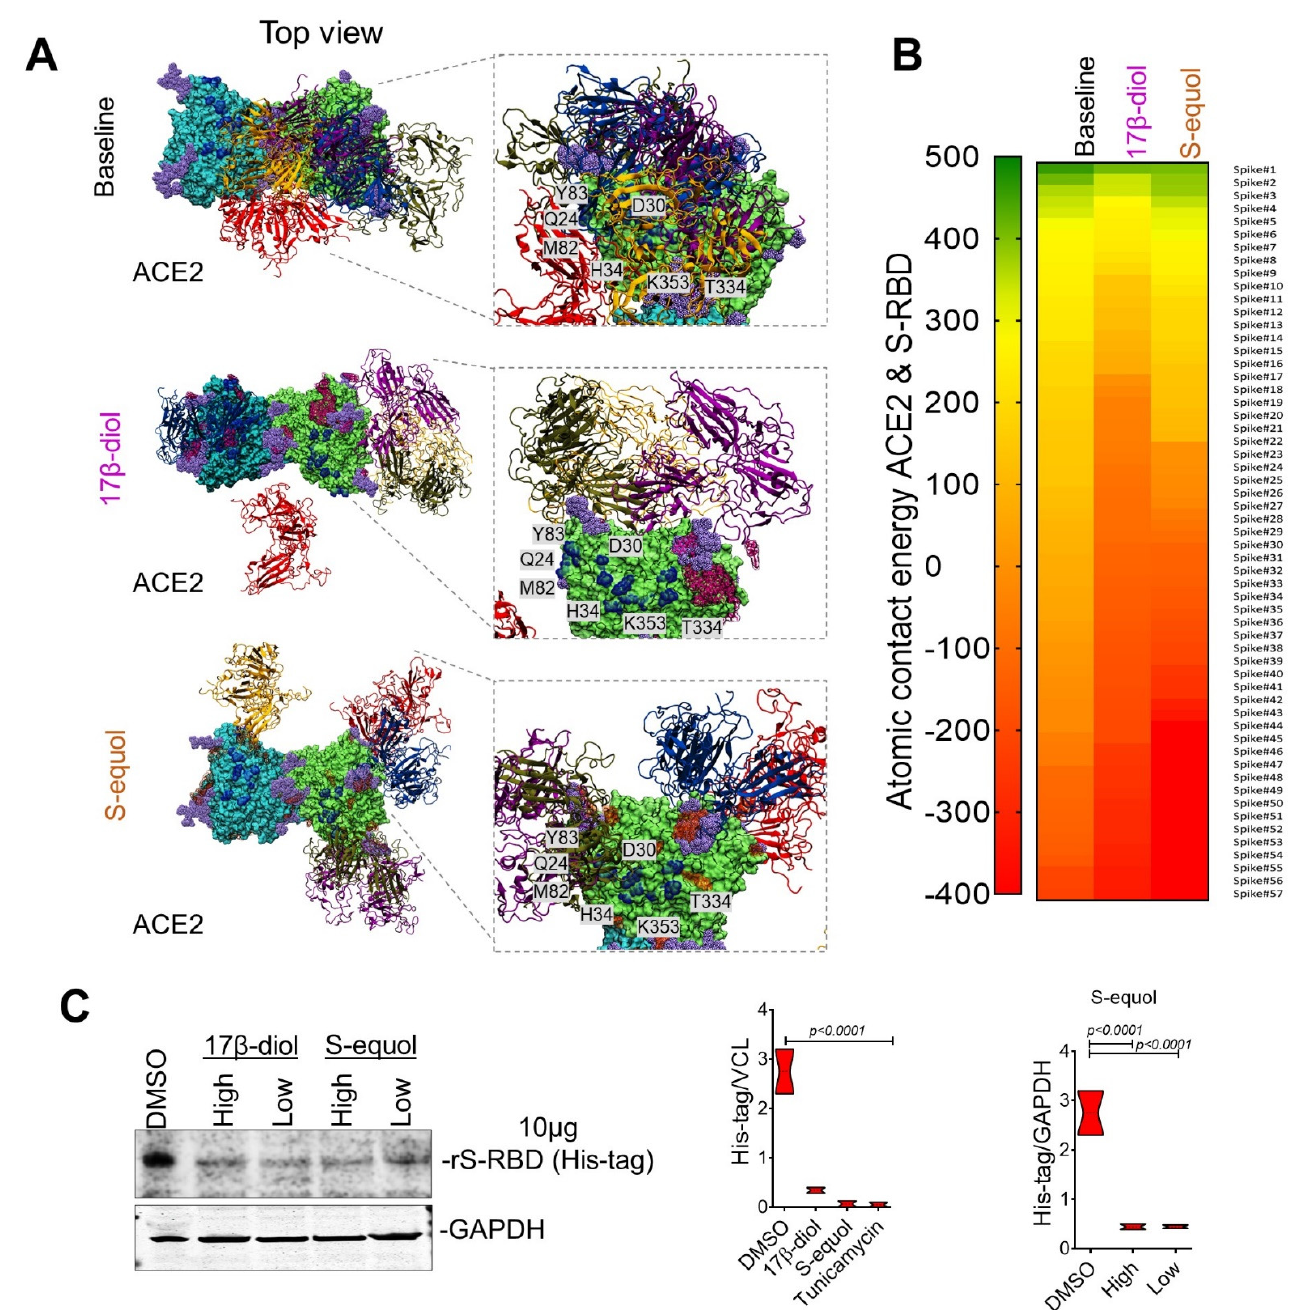
Figure 4. Estrogen’s impact on ACE2 and S-RBD interactions. ( A ) Top view of the 3D ACE2 surface interacting with 5 top-scored S-RBDs (top 1—blue, 2—red, 3—orange, 4—purple, and top 5—yellow). S-RBDs were scored based on shape complementarity principles. ( B ) Heatmap of atomic contact energy between ACE2 and 57 S-RBDs shows spontaneous energy structures from most favorable (green) to less favorable S-RBD structures (red). Energy scale ranging from 500 Kcal/mol to − 500 Kcal/mol. ( C ) Immunoblot of isolated proteins from cultured HUVECs shows a 90% inhibition of S-RBD entry into cells in estrogen-treated cells. Quantification of protein levels of three replicate experiments is shown. Student’s T -test, 2 tails. Bar graphs are presented as mean with error bars (±SD).